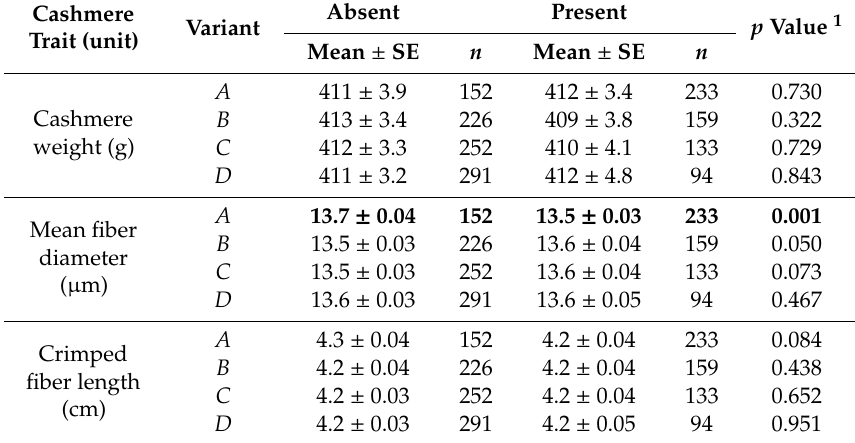
Table 1. Association of KRTAP28-1 variants with various cashmere traits (mean ± SE) 1 in Longdong cashmere goats.